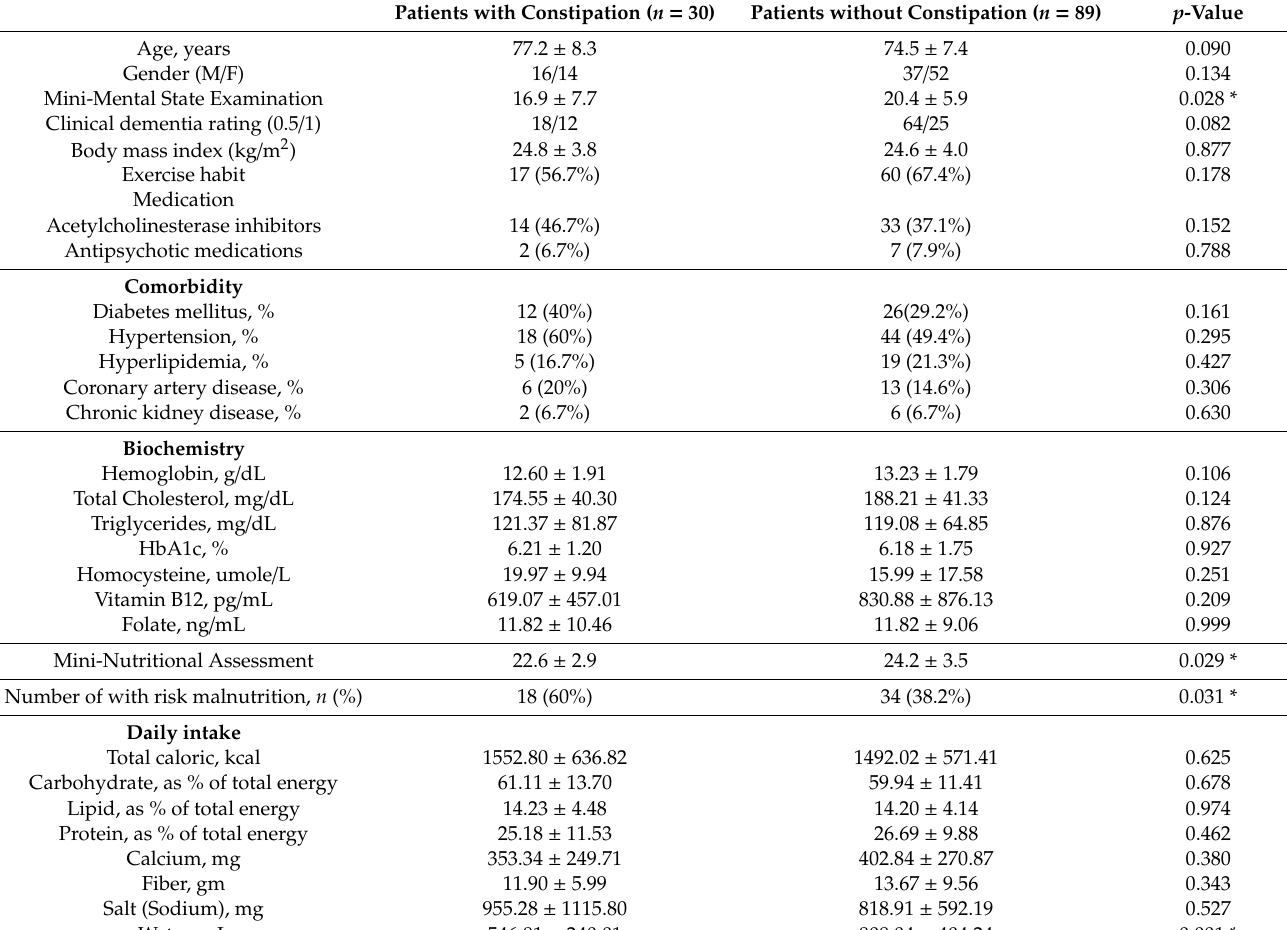
Table 3. Clinical and biochemical characteristics and the daily intake subgroup